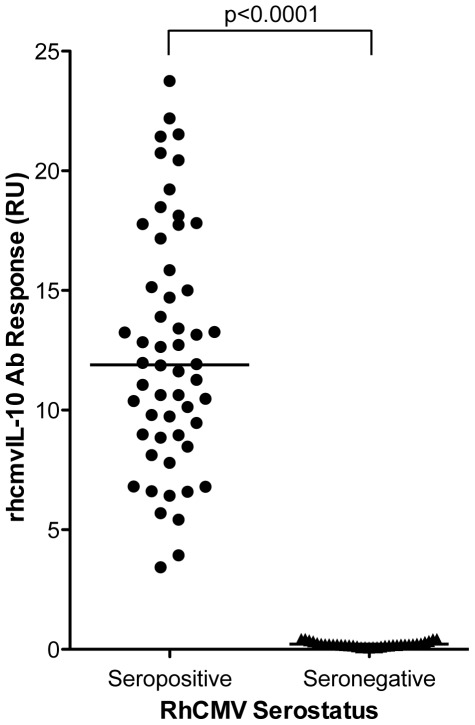
rhcmvIL-10 antibody seroprevalence in rhesus macaques.Plasma samples from macaques confirmed positive or negative for RhCMV (54 RhCMV seropositive, 35 seronegative) were screened for the presence of rhcmvIL-10 antibodies by rhcmvIL-10 ELISA. RhCMV seropositive samples had significantly higher rhcmvIL-10 antibody levels than seronegative samples (p<0.0001; two-tailed unpaired student's t-test) with a range of 3 to 24 Relative Units (RU). The line represents the median for the group.